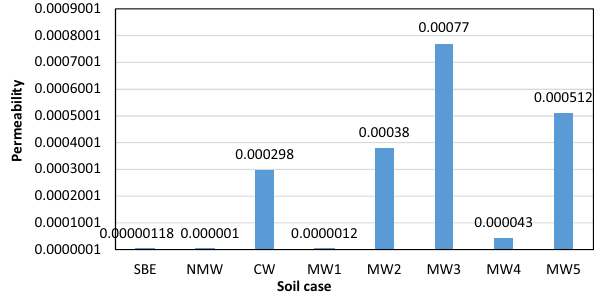
Figure 5: The permeability of the